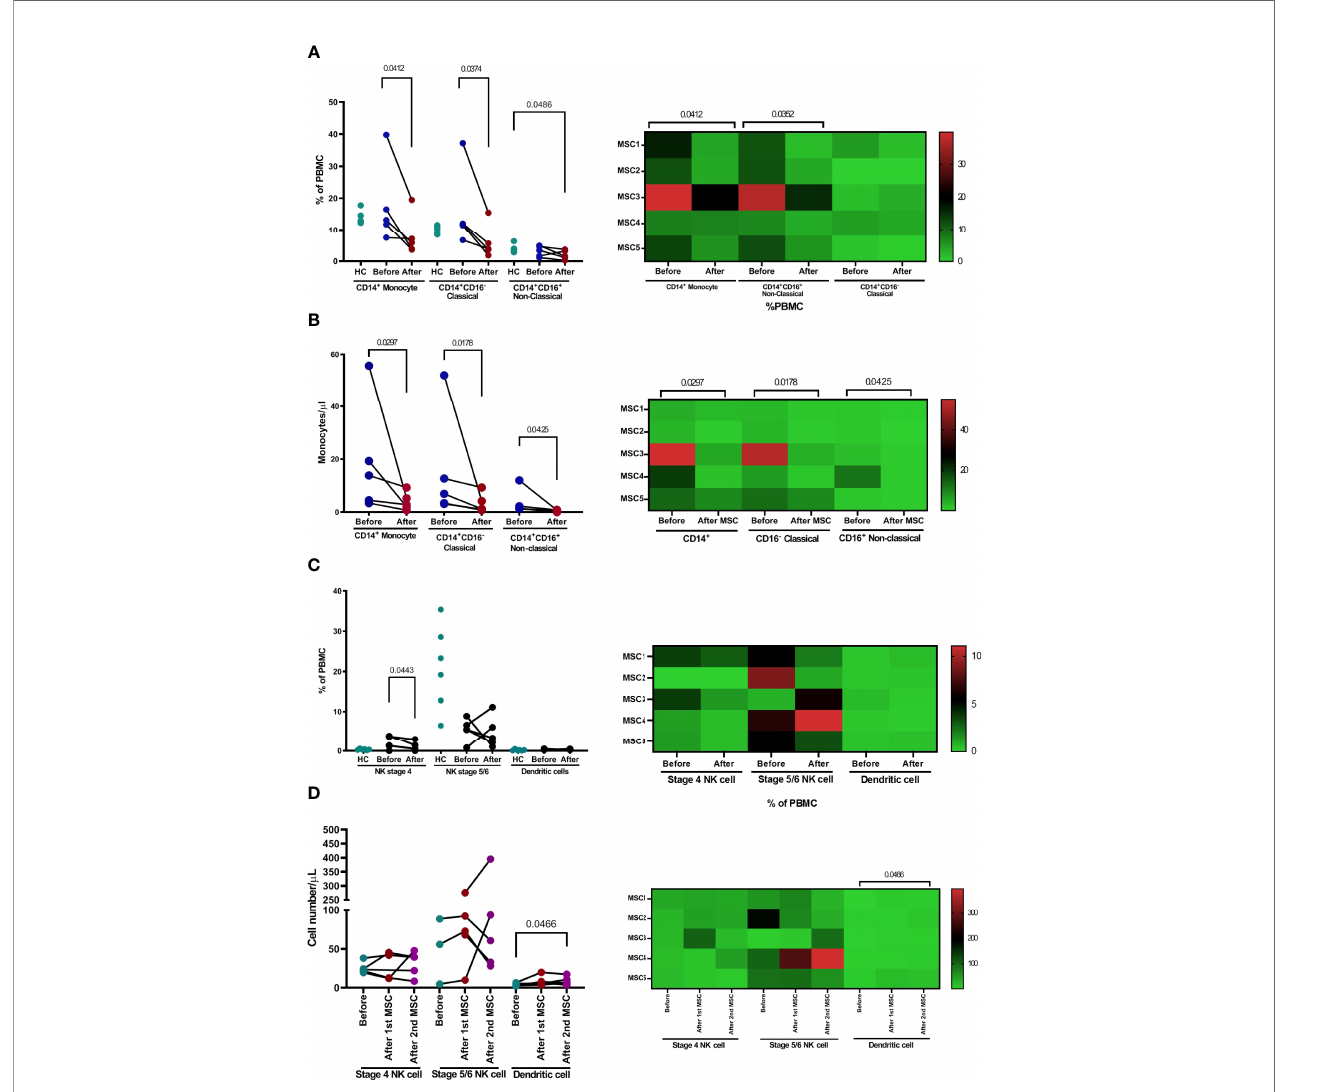
FIGURE 6 | The changes of monocyte and NK cell population after pcMSC treatment. (A) The proportion and (B) the absolute number of total monocytes, classical monocytes, and non-classical monocytes were reduced after treatment. (C) The proportions of dendritic cells, NKT cells, and subpopulations were not signi fi cantly changed after treatment, compared with corresponding healthy controls. (D) The absolute number of dendritic cells, but not NK cells, or subpopulations, increased after Day 8 of treatment. *P <0.05 and **P <0.01, nonparametric Wilcoxon sign-rank